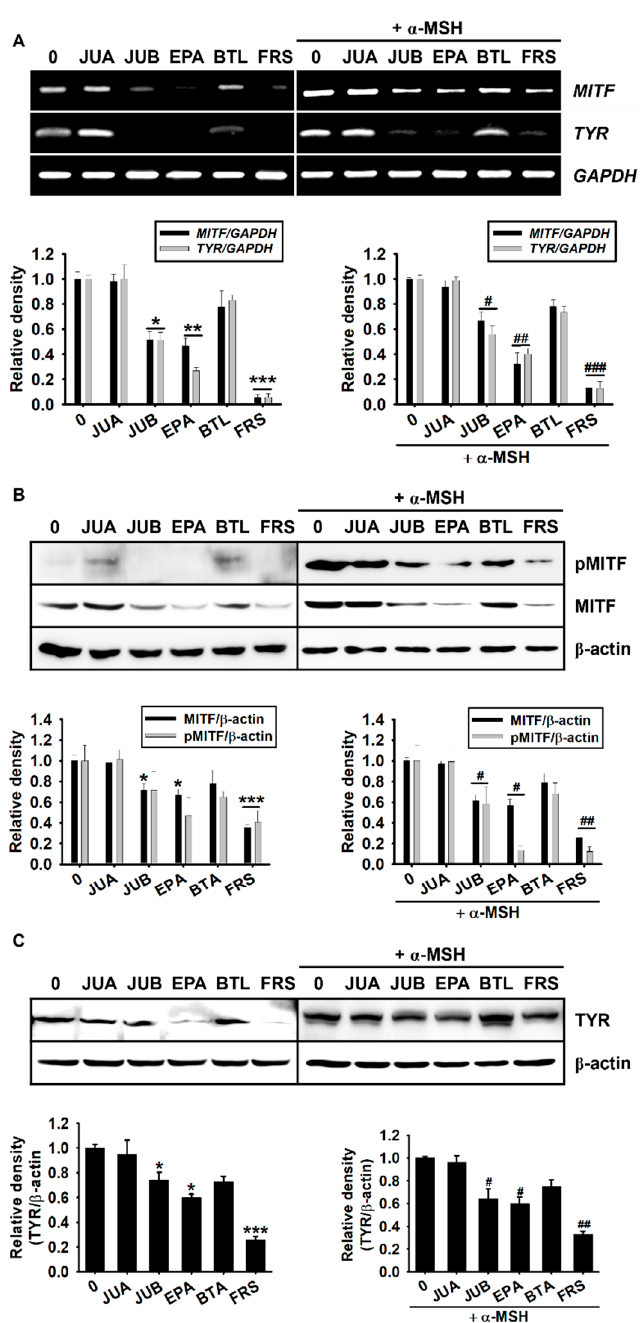
Figure 5. JUB, BTL, and FRS from Z. jujuba var. inermis (Bunge) Rehder seed downregulated MITF and tyrosinase (TYR) expression. B16F10 melanoma cells (5 × 10 4 cells/mL) were treated with 20 µM of jujuboside A (JUA), jujuboside B (JUB), epiceanothic acid (EPA), betulin (BTL), and 6’’’- feruloylspinosin (FRS) in the absence ( left ) and presence ( right ) of 500 ng/mL of α -melanocyte- stimulating hormone ( α -MSH). ( A ) Reverse transcription-polymerase chain reaction (RT-PCR) was performed at 48 h to evaluate the gene expression of microphthalmia-associated transcription factor ( MITF ) and tyrosinase ( TYR ). Glyceraldehyde 3-phosphate dehydrogenase ( GAPDH ) was used as a loading control. ( B , C ) Western blotting was performed at 96 h to evaluate the protein expression of ( B ) pMITF and MITF and ( C ) TYR. β -Actin was used as the internal control. Relative densities were calculated from ImageJ software and intensity levels were normalized to the levels of ( A ) GAPDH and ( B , C ) β -actin. All data are presented as standard errors of the median from three independent experiments (*** p < 0.001, ** p < 0.01, and * p < 0.05 vs. untreated cells; ### p < 0.001, ## p < 0.01, and # p < 0.05 vs. α -MSH-treated cells).